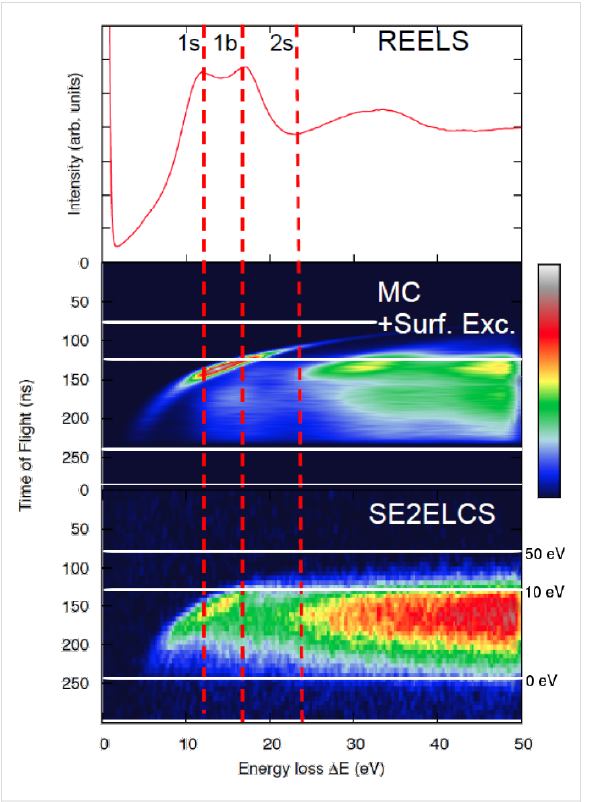
Figure 5: Same as Figure 4 with the inclusion of surface excitations in the modelling of electron transport through the solid-vacuum interface.